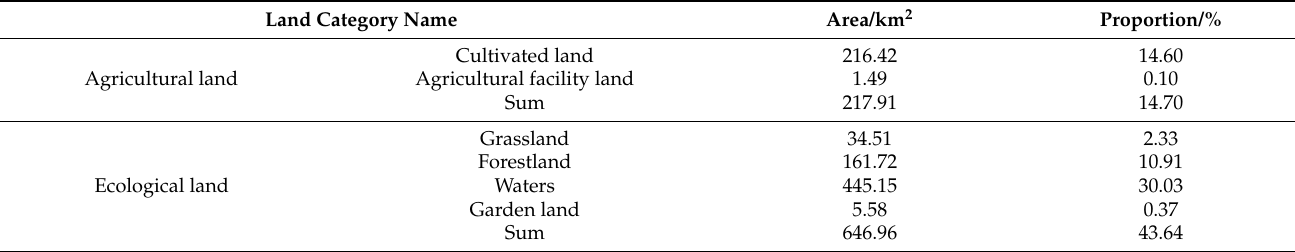
Figure 12. Distribution Map of Land Use Types in the Urban-Rural Fringe of Wuhan City. Under the evolution of the history of three towns and the “gene” of big rivers and mountains, the urban-rural fringe of Wuhan City, affected by transportation, economy, and policies, presents a “six axes, two rings” banded and leaping distribution characteristics around the main urban core area of Wuhan. The “six axes” are Yangluo—Shamao Yangtze River Expansion Axis, Zoumaling—Caidian Han River Expansion Axis, Baoxie—Zuoling to Ezhou Expansion Axis, Songjiagang—Boquan to Xiaogan Expansion Axis, Zhifang to Xianning expansion axis, Dunyang—Changfu to Xiantao Expansion Axis, and the “two rings” refer to Qianchuan—Sheshui Jumping Expansion Ring and Zhucheng—Jushui Jumping Expansion Ring. It can be seen that the distribution and trend of large rivers, as well as the deep communication and integration of the Wuhan City circle, have a profound impact on the spatial morphology of the URF of Wuhan (Figure 13). Table 3. Area Statistics of Land Use Types in the Urban-Rural Fringe of Wuhan